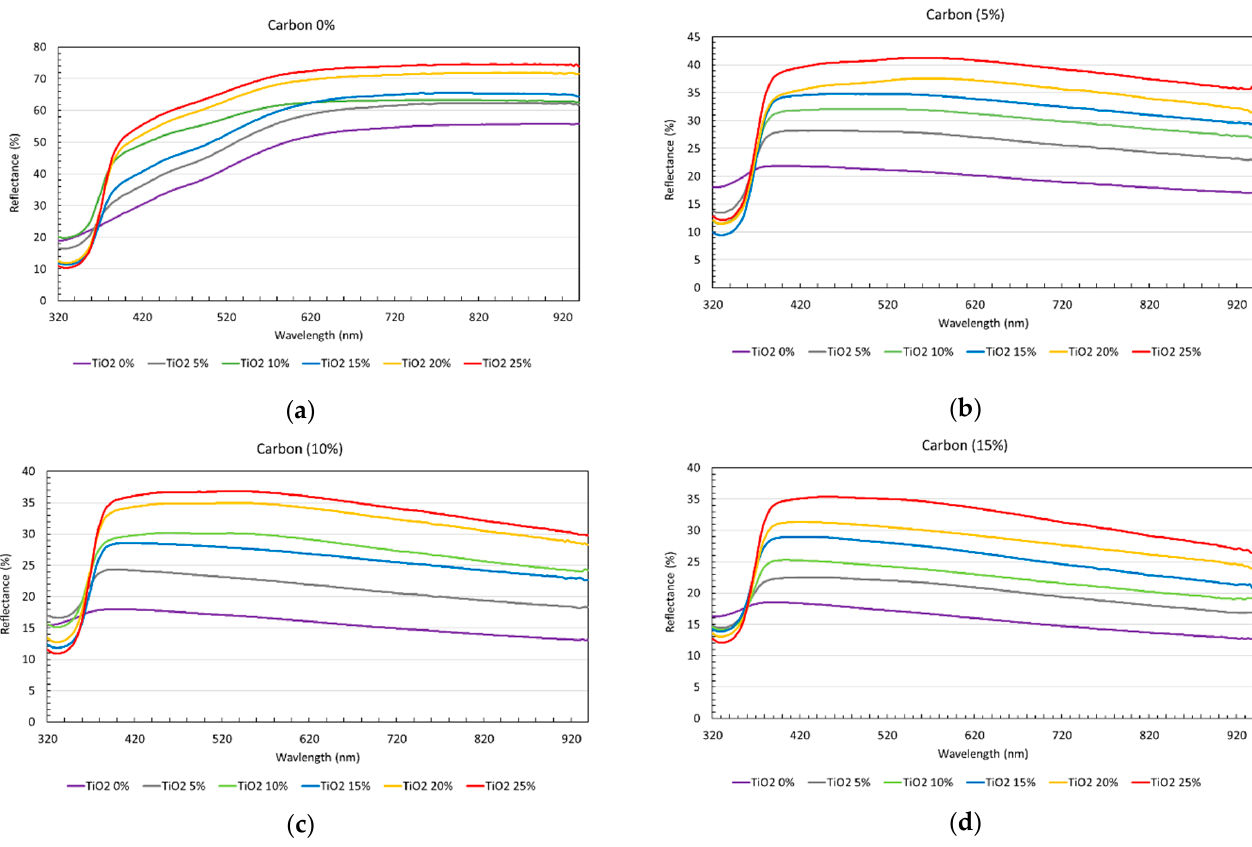
Figure 7. Reflectance curves of cementitious base samples with varying TiO 2 contents. Each subfigure corresponds to a different carbon level: ( a ) 0%, ( b ) 5%, ( c ) 10%, and ( d ) 15%.